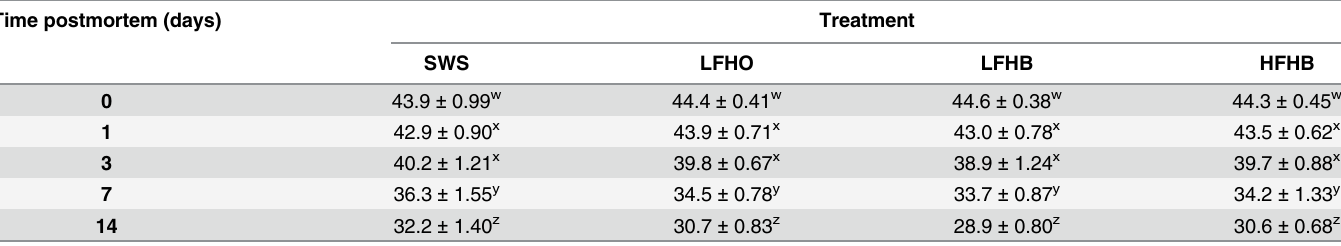
Table 3. Free thiol (SH) content (nmole/mg protein) of longissimus lumborum muscle during postmortem aging periods in goats subjected to slaughter without stunning and slaughter following different methods of electrical stunning (mean ± SE, n = 8). Time postmortem